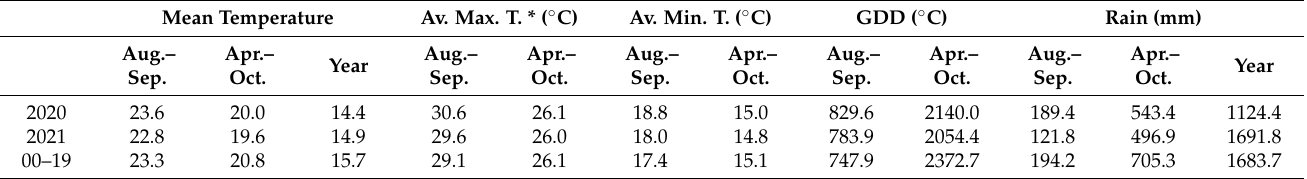
Table 1. Basic climatic conditions at the Trebinje locality during 2020–2021 and average data for the period of